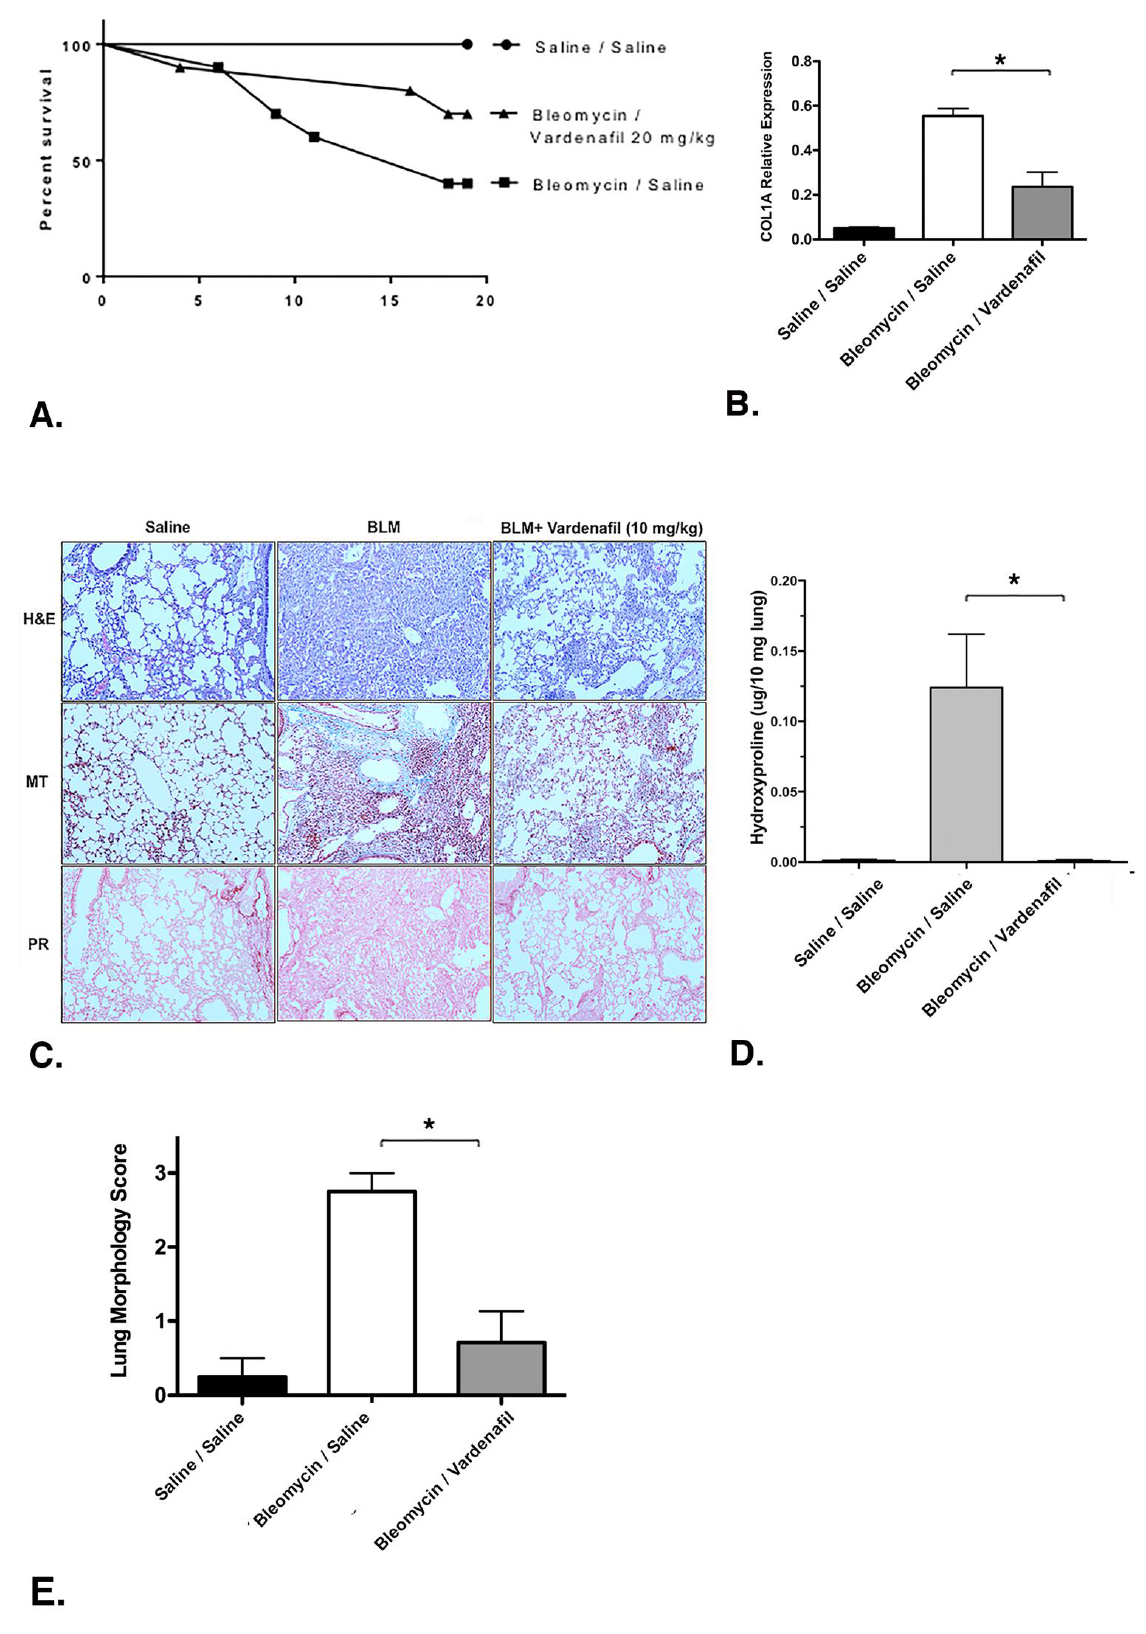
Figure 7. Vardenafil improved survival and reduced collagen production in a bleomycin model of lung injury and fibrosis. The mice received intratracheal bleomycin and were treated with vardenafil over 19 days, as detailed under Materials